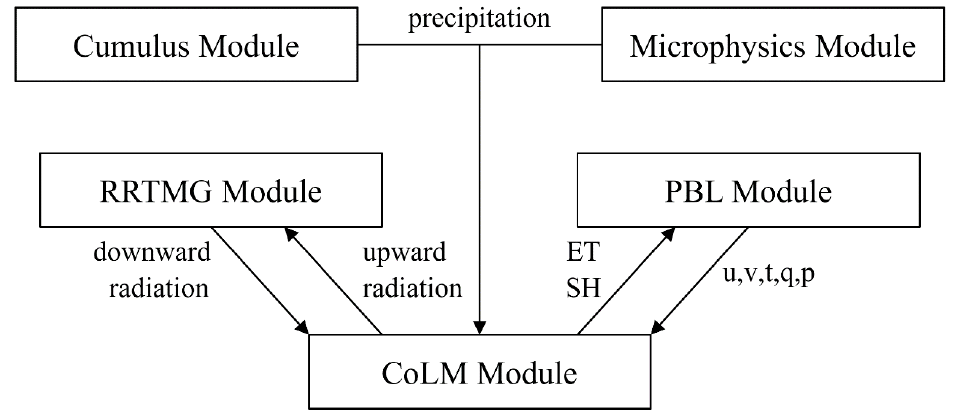
Figure 1. How CoLM is coupled with other physical modules in GRAPES.